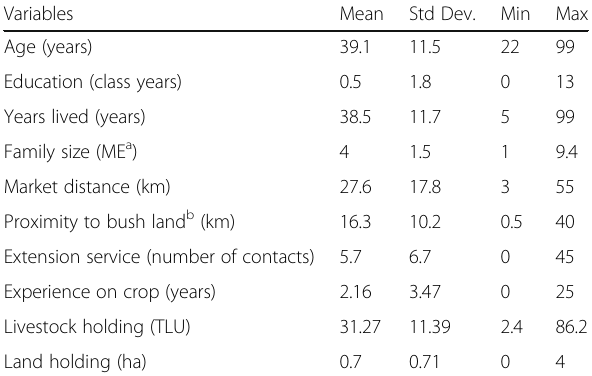
Table 2 Descriptive statistics results (continuous